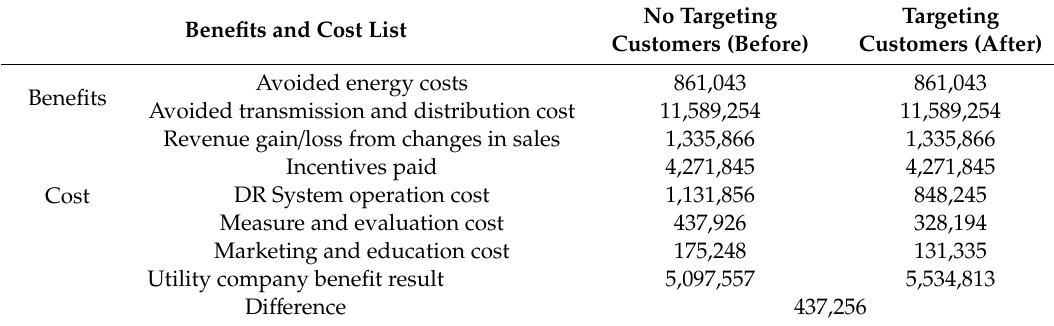
Table 5. Cost-E ff ectiveness Analysis Changes by Incentive DR Targeting (Unit: